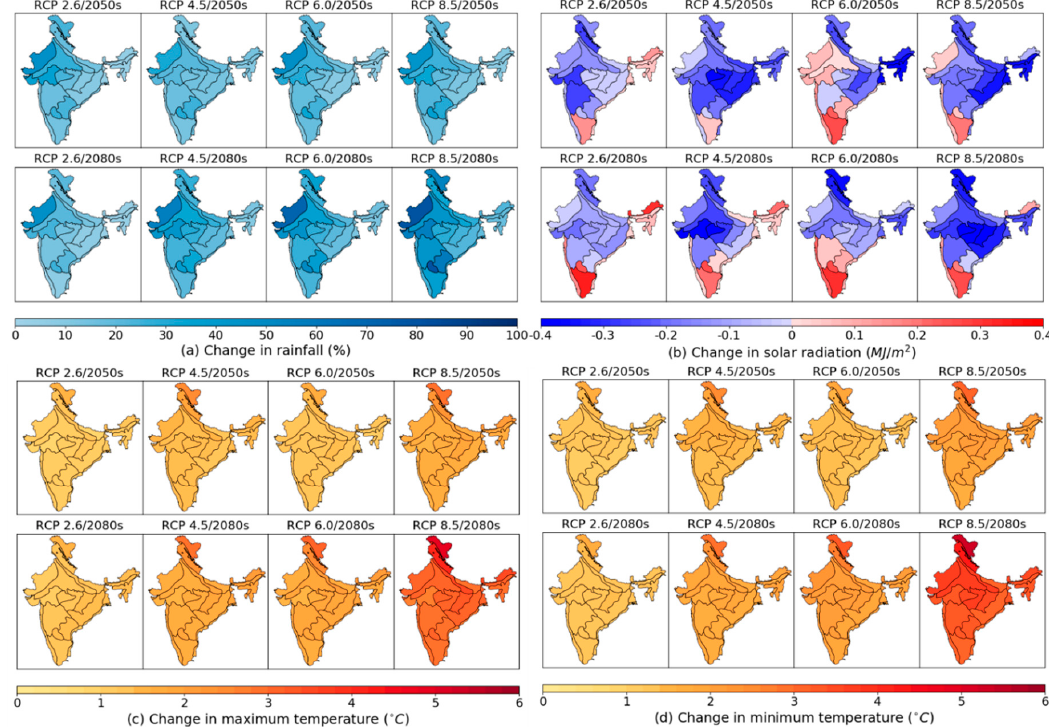
Figure 7. Climate change analyzed based on mean changes in summer (Apr.–Sep.) in ( a ) rainfall, ( b ) solar radiation, ( c ) maximum, and ( d ) minimum temperature with respect to 1990s for two future periods—2050s and 2080s and all the RCP